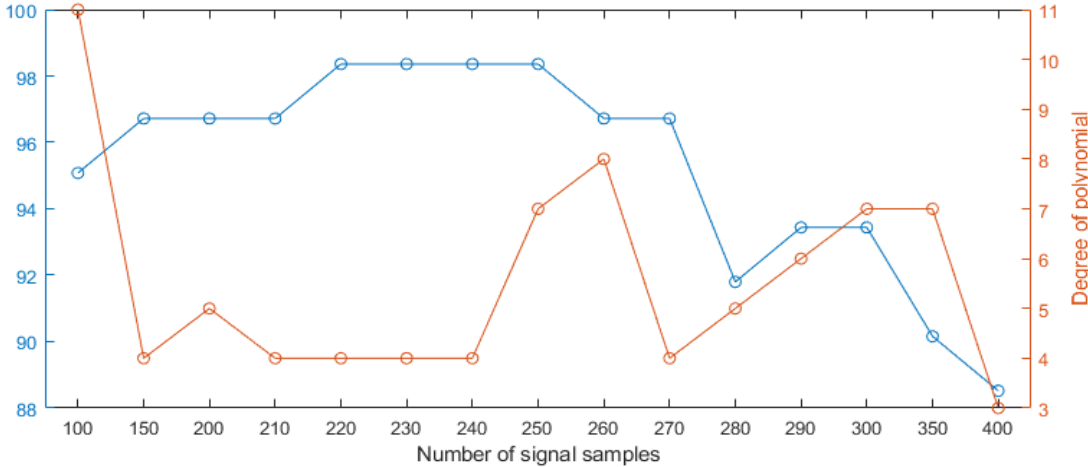
Figure 7. Classification accuracy in relation to the signal length and the minimum degree of the polynomial to achieve the indicated accuracy.